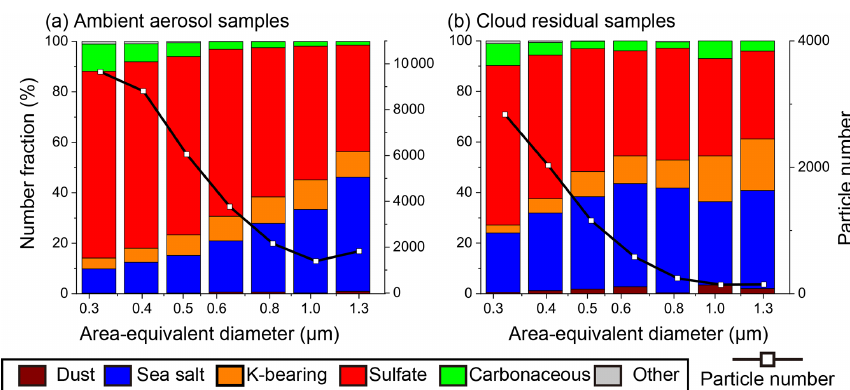
Figure 7. Size-dependent number fractions of ambient aerosol and cloud residual particles and their number distributions. (a) Ambient aerosol particles ( N = 33652) and (b) cloud residual particles ( N = 7138). The TEM samples used in (a) and (b) are 194 and 45, respectively.